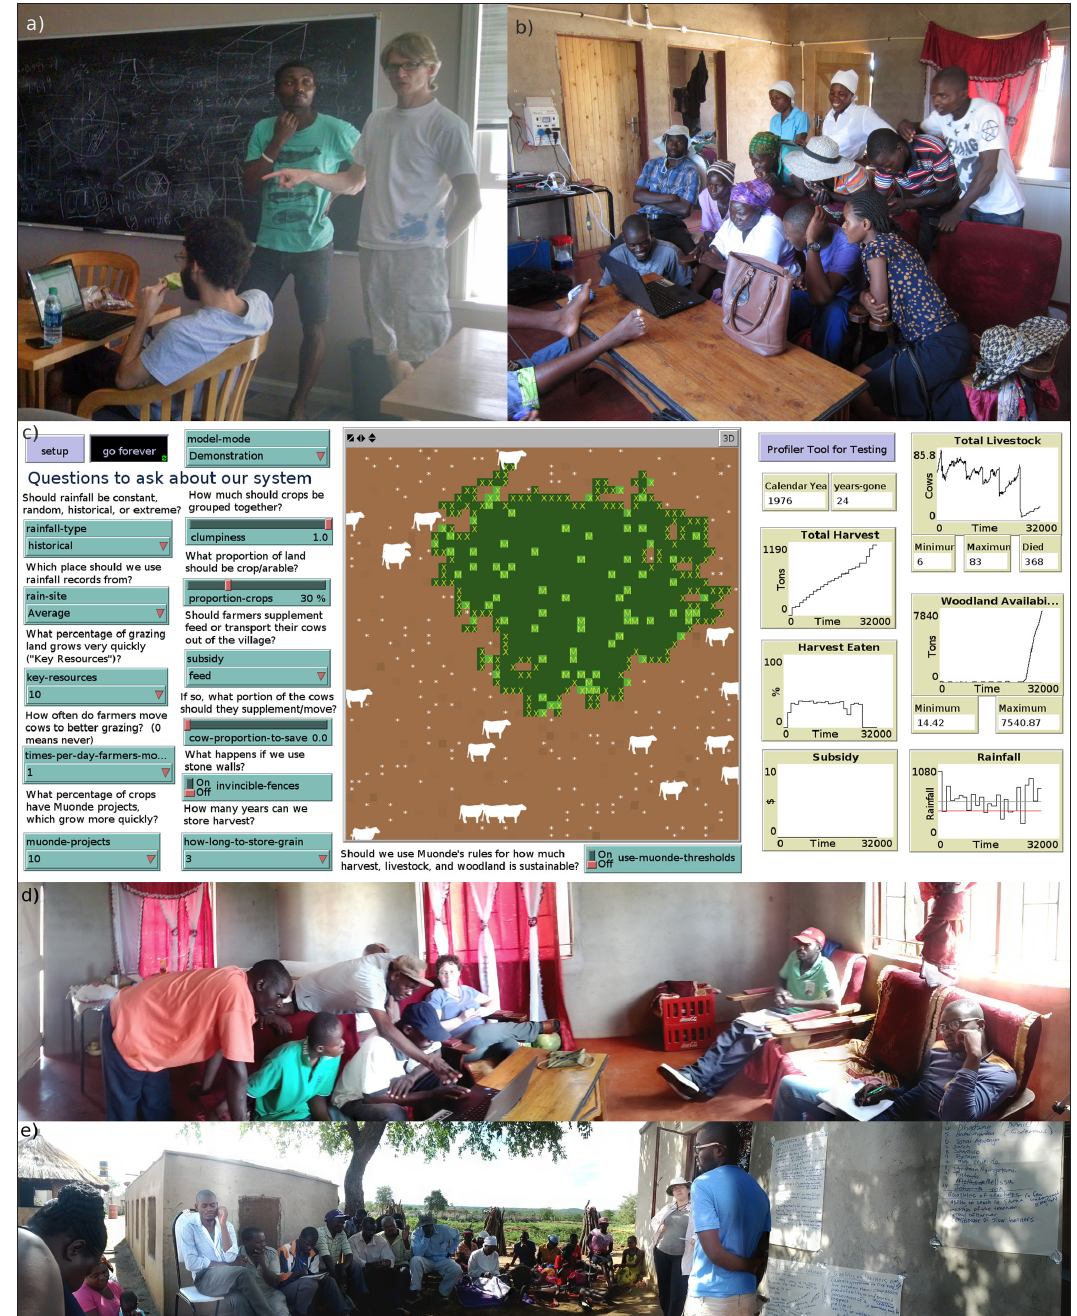
Figure 1 The modeling process. (a) Initial model development at Santa Fe Institute Complex Systems Summer School, showing coauthors with quantitative modeling skills discussing an early stage of the model; these coauthors were also learning to program in NetLogo and corresponding with Muonde Trust researchers via videoconference (Skype). (b) Small-group workshop with Muonde Trust coauthors demonstrating and explaining the model to the other members of the community-based research team. (c) Computer screen capture of the final version of the model while it is running, at left showing the choices made by the user, in the middle displaying the visualization of the model’s current state (showing cows’ position, the spatial configuration of the crops and woodland, and how much biomass is on each patch—brighter colors have more biomass), and on the right tracing the behavior of key variables over the course of the simulation (for example, rainfall, numbers of cows, and accumulated total harvest). This is the interface developed by the Santa Fe Institute summer school participants in (a), and it is the interface the Muonde Trust researchers are interacting with in (b) and (d) (and later showed to local leaders). (d) Small-group workshop showing note taking by observers (also Muonde Trust researchers). (e) Whole- group workshop to discuss the real system and how the model generates new thoughts on its management (facilitated by outsider researcher, with assistance and translation from Muonde Trust researchers). Photo credits: M.V. Eitzel, J. Solera; used with permission of all those